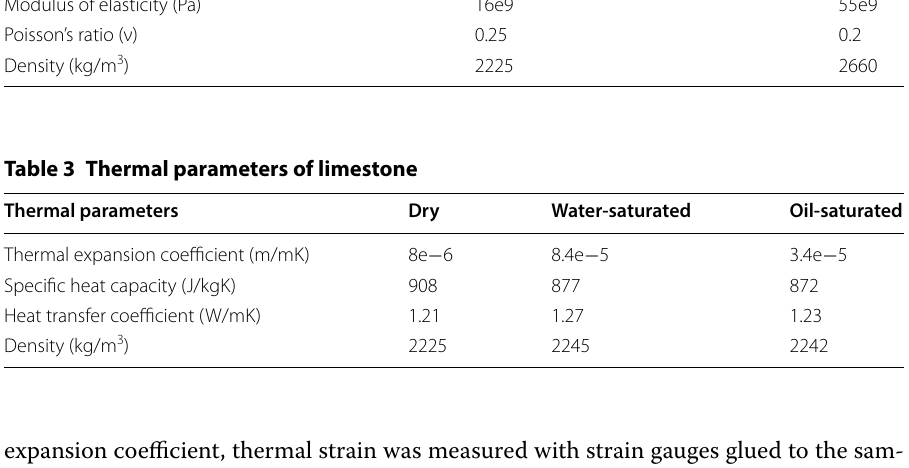
Table 2 Geomechanical properties of samples [2] Parameter